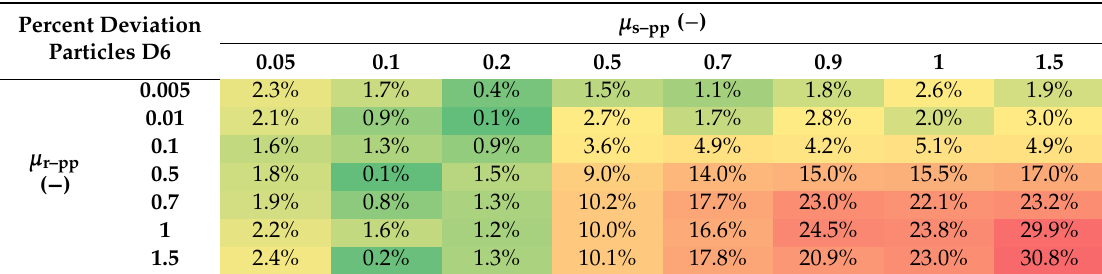
Table 4. The first estimation of frictional parameters via packing test for D6 particles.